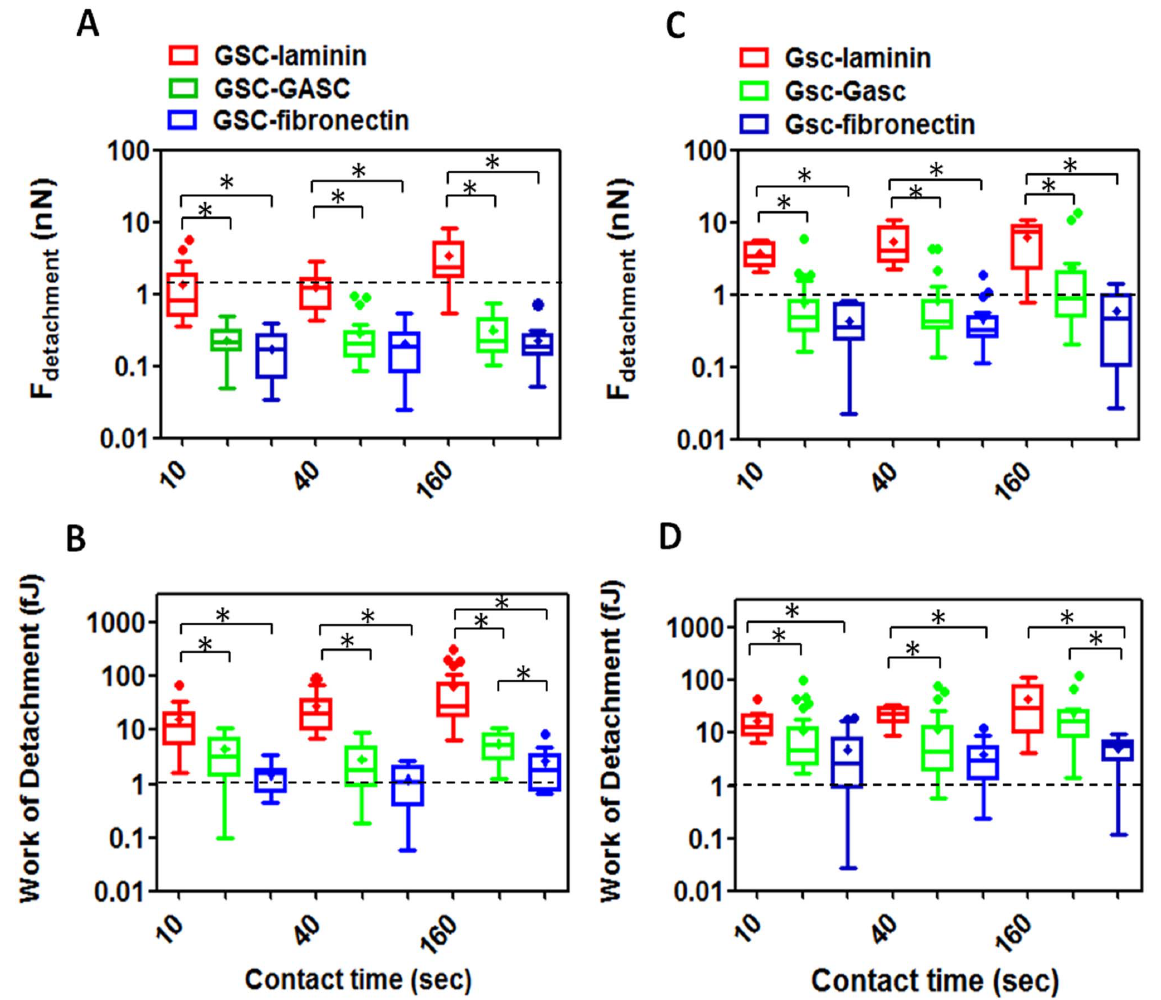
Figure 4. Time dependent analysis of detachment force and work. ( A–B ) Data obtained for GSC-GASC compared with GSC-laminin and GSC- fibronectin and ( C–D ) Gsc-Gasc compared with Gsc-laminin and Gsc-fibronectin; the values inside the box represent the first (25%) and third quartile N (75%), while the line within the box represents the median value (50%); the (–) indicate the maximum and minimum observations; while outliers are ); the mean value is indicated in the plot as ( + ); (*) p value , 0.05 is considered statistically significant. ( A–B ) Detachment force and indicated by ( work of GSC-laminin are significantly higher than that obtained for GSC-GASC or GSC-fibronectin for each contact time investigated (p , 0.0001); No significant differences are obtained between GSC-GASC and GSC-fibronectin, except for work of detachment at 160 sec (p=0.0097). ( C–D ) The detachment force of Gsc-laminin is higher than that obtained for Gsc-Gasc (p , 0.00001 for 10 sec and 40 sec, p=0.0118 for 160 sec) and Gsc- fibronectin (p , 0.00001 for 10 sec and 40 sec, p=0.0005 for 160 sec). The work of detachment of Gsc-laminin is significantly higher than that obtained for Gsc-Gasc (p=0.0042) at 10 sec and (p=0.0006) at 40 sec contact time, while at 160 sec they are no significantly different (p=0.1167); the work of detachment of Gsc-laminin is higher than that obtained for Gsc-fibronectin for all the contact time investigated (p=0.0004 for 10 sec, p , 0.0001 for 40 sec, p=0.0006 for 160 sec). No significant differences were obtained between Gsc-Gasc and Gsc-fibronectin, except for work of detachment at 160 sec (p=0.0004). For a better visualization and comparison of the data, Y scale is reported as Log